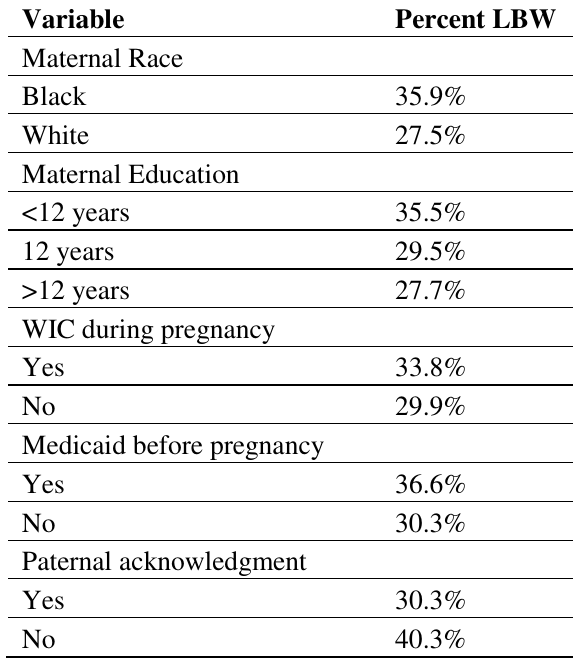
Table A2. Prevalence of LBW by race and selected SEP measures.